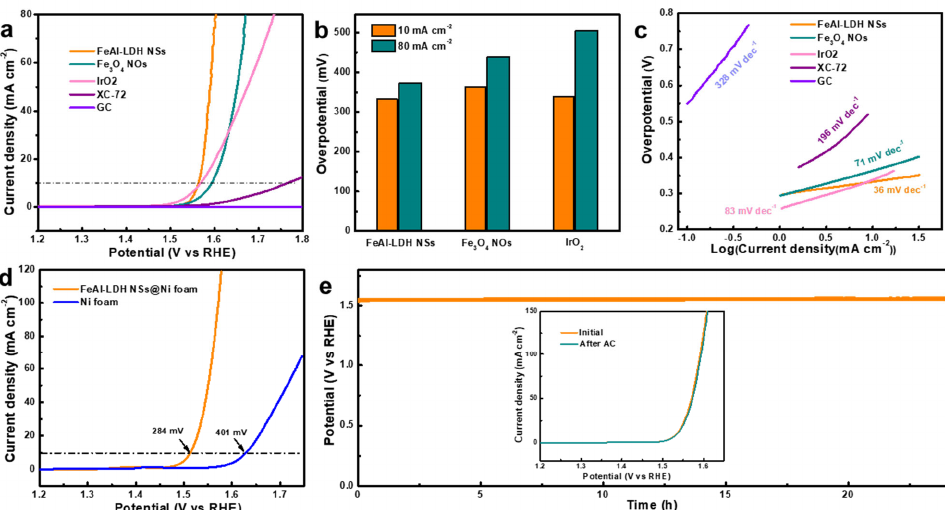
Figure 6. ( a ) OER polarization curves, ( b ) overpotentials at 10 and 80 mA cm − 2 , and ( c ) the related Tafel slopes of different catalysts loaded on GCE at 5 mV s − 1 in 1 M KOH solution. ( d ) OER polarization curves of FeAl ‐ LDH NSs loaded on Ni foam and barely Ni foam at 5 mV s − 1 in 1 M KOH solution. ( e ) Long ‐ term stability results of the FeAl ‐ LDH NSs@Ni foam electrode with a constant current density of 10 mA cm − 2 with inset ( e ) polarization curves of FeAl ‐ LDH NSs@Ni foam before and after the stability measurement.